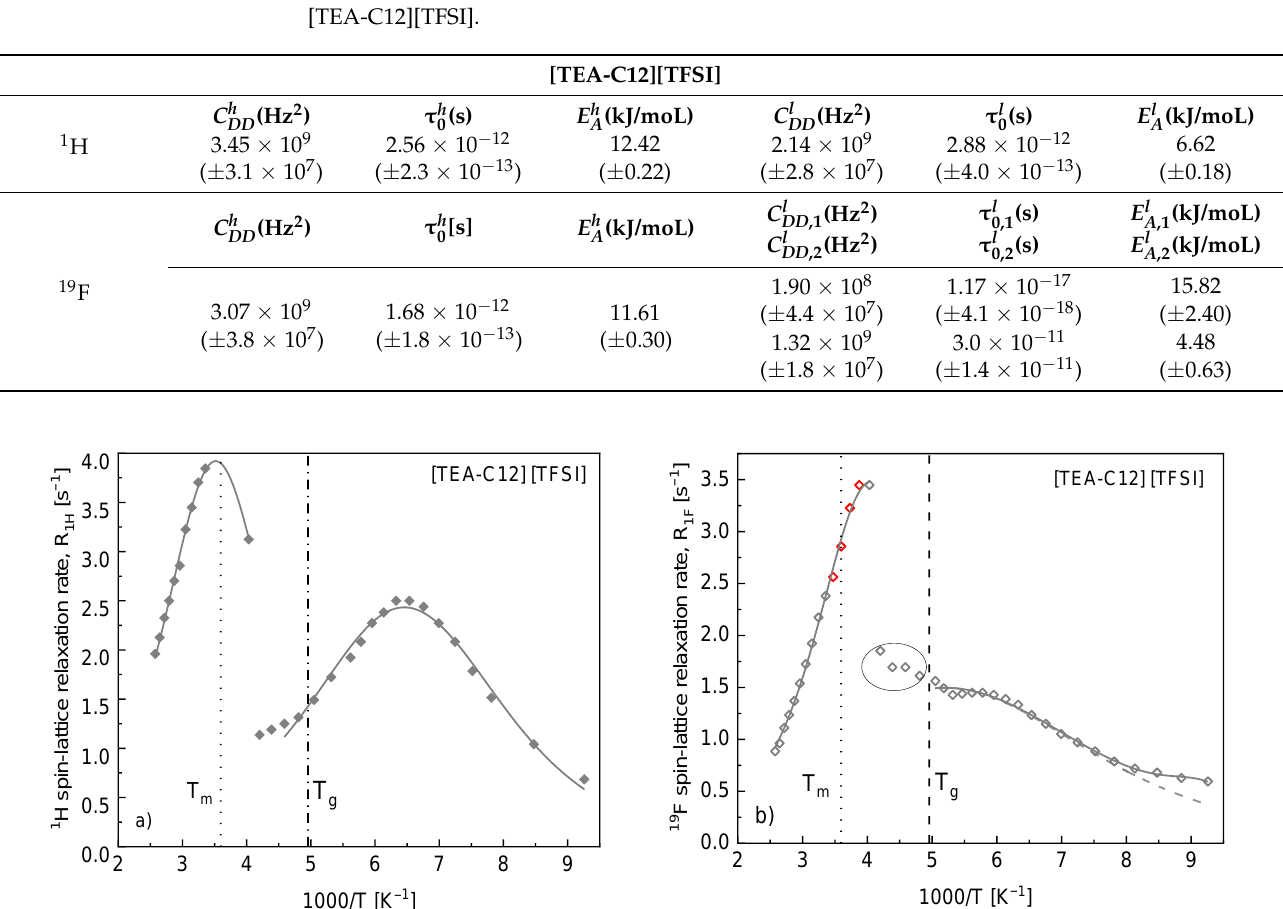
Figure 4. 1 H ( a ) and 19 F ( b ) spin-lattice relaxation rates versus reciprocal temperature for [TEA- C12][TFSI]. Solid lines — fits with parameters collected in Table 3, dashed line in ( b ) — relaxation con- tribution related to the parameters 𝐶 𝐷𝐷,2𝑙 , 𝜏 0,2𝑙 , 𝐸 𝐴,2𝑙 , vertical lines indicate phase transition tempera- tures ( 𝑇 𝑚 = 278.20 K, 𝑇 𝑔 = 201.77 K [26]).